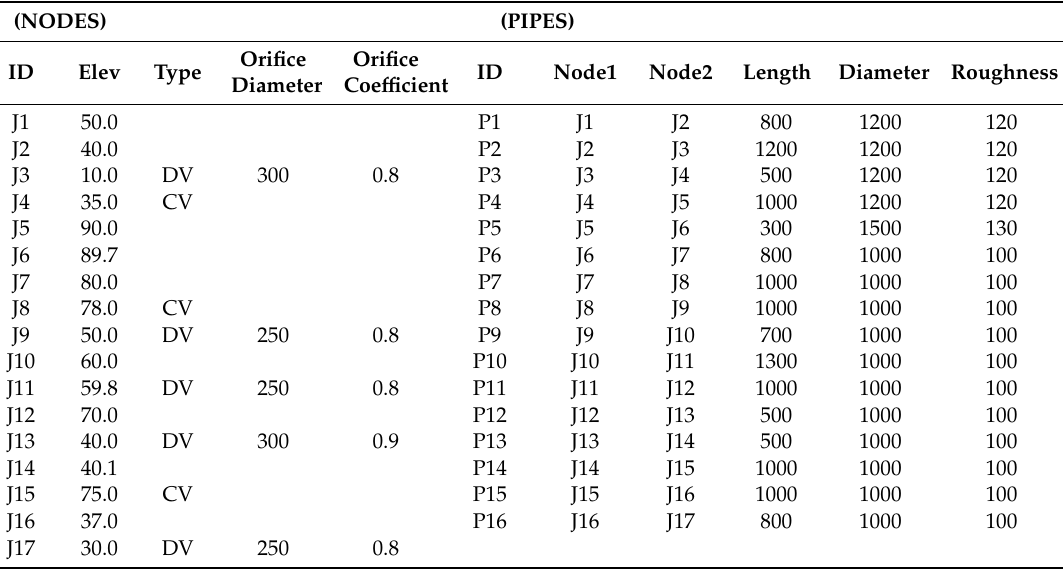
Table 1. Input file for the valve location